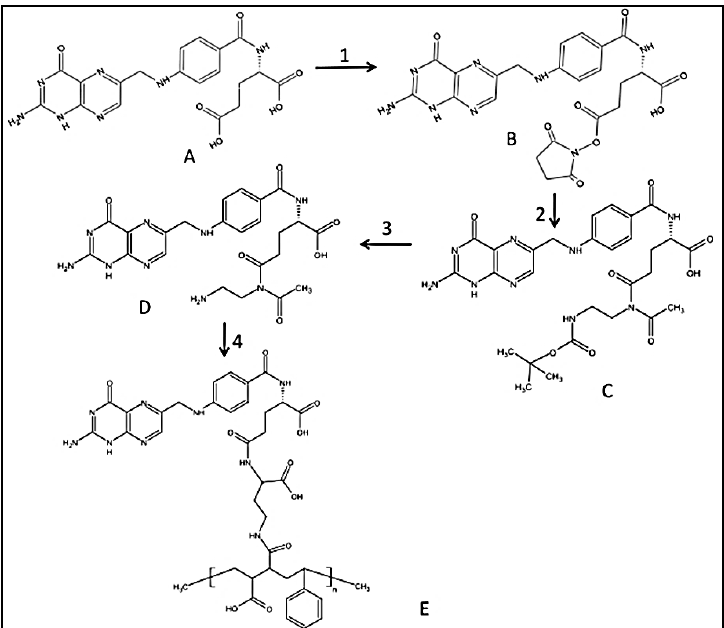
Figure 1. Synthetic pathway to PSMA-folic conjugates. (1) DCC/NHS Folic acid activation; (2) boc-DABA reacting with FA-NHS in DMSO, room temperature (r.t.) overnight; (3). TFA/DCM wash with TEA/DCM and precipitate with water; (4). DCC/NHS with PSMA in DMSO, r.t. overnight. Reproduced with permission from Li et al. [13].